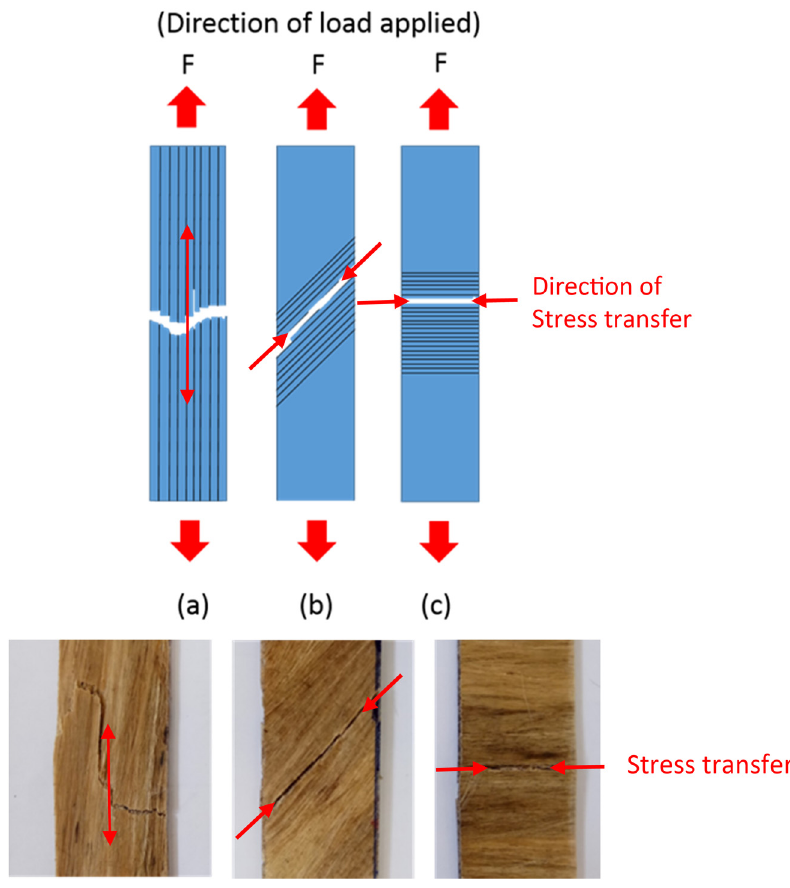
Figure 7: Failure of the PLA – kenaf composites with fi ber orientations of ( a ) 0°, ( b ) 45°, and ( c ) 90° during tensile